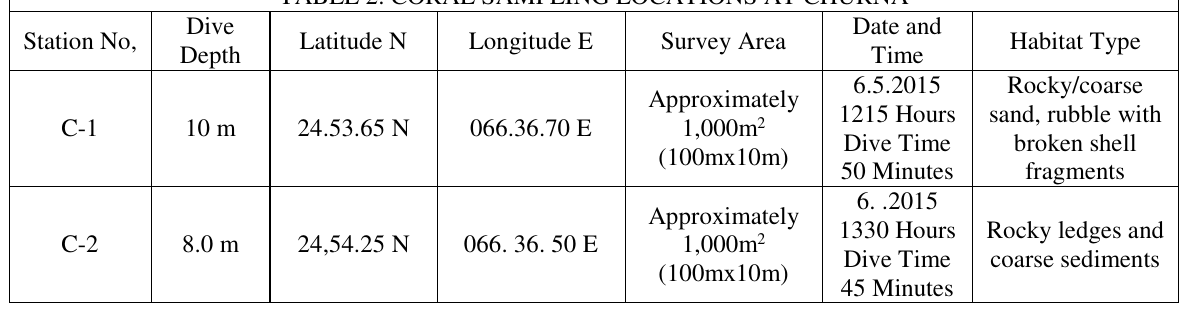
TABLE 3. MARINE BENTHIC INVERTEBRATES ABUNDANCE AND DISTRIBUTION